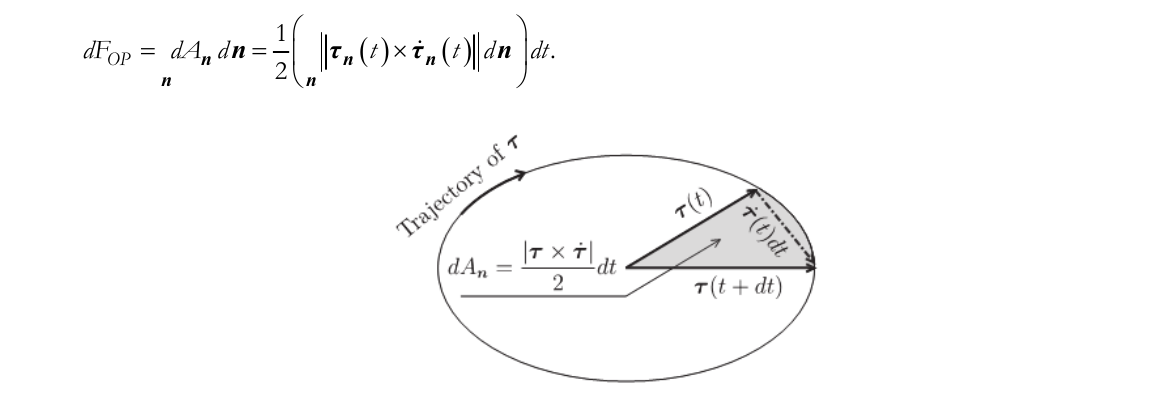
Figure 2: Trajectory of the shear stress vector in a given plane and the area dA n